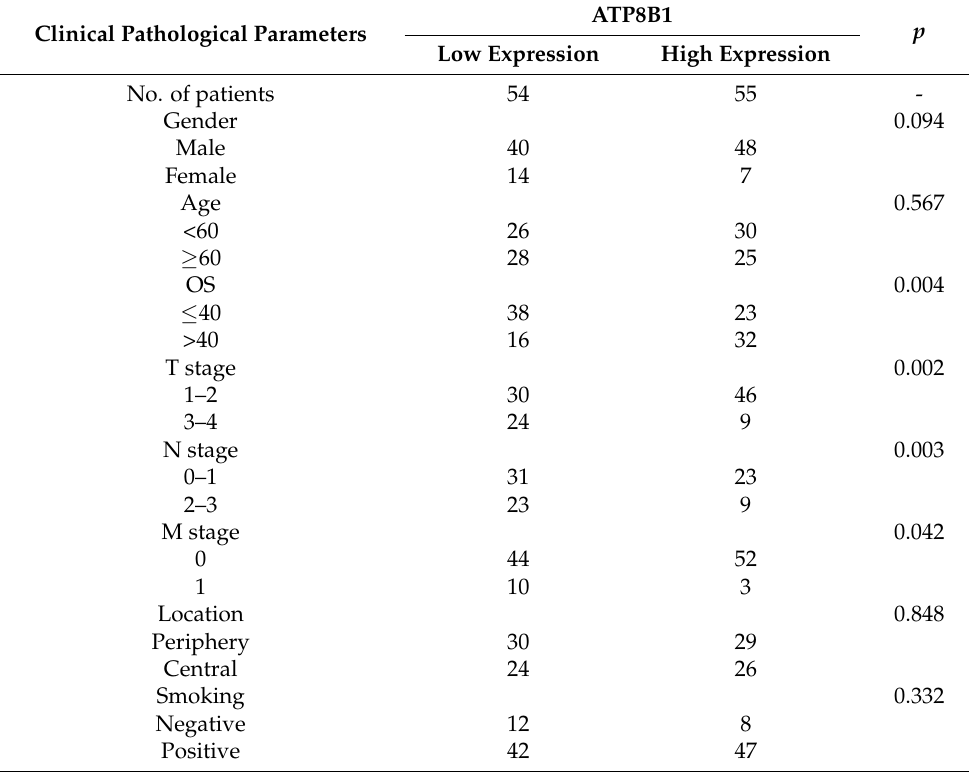
Table 2. Distributions of the clinical pathological parameters of patients with different ATP8B1 expression